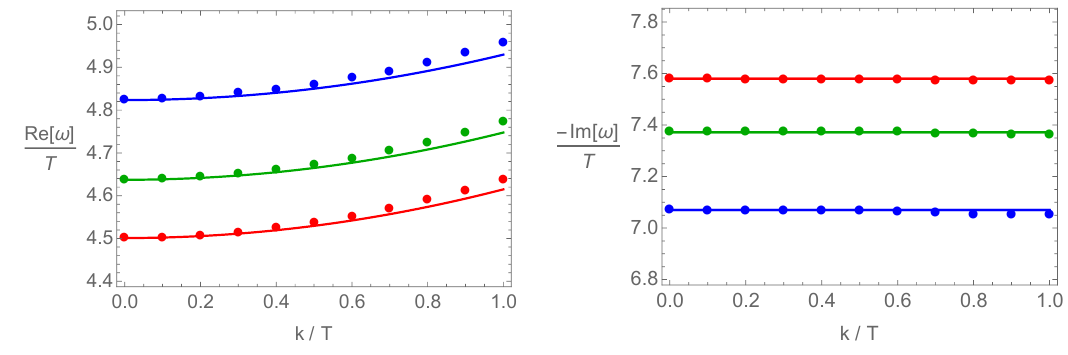
Figure 17 . The dispersion relation of the Higgs mode at low temperature: T/T c = (0 . 15 , 0 . 21 , 0 . 25) (blue, green, red). Left: Re[ ω ] vs. k . Right: Im[ ω ] vs. k . The solid lines are the predictions from GL theory, eq.